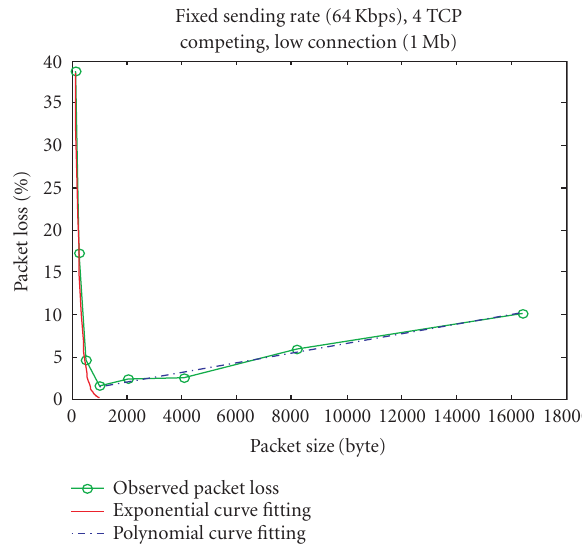
Figure 10: Packet loss versus packet size in a congested